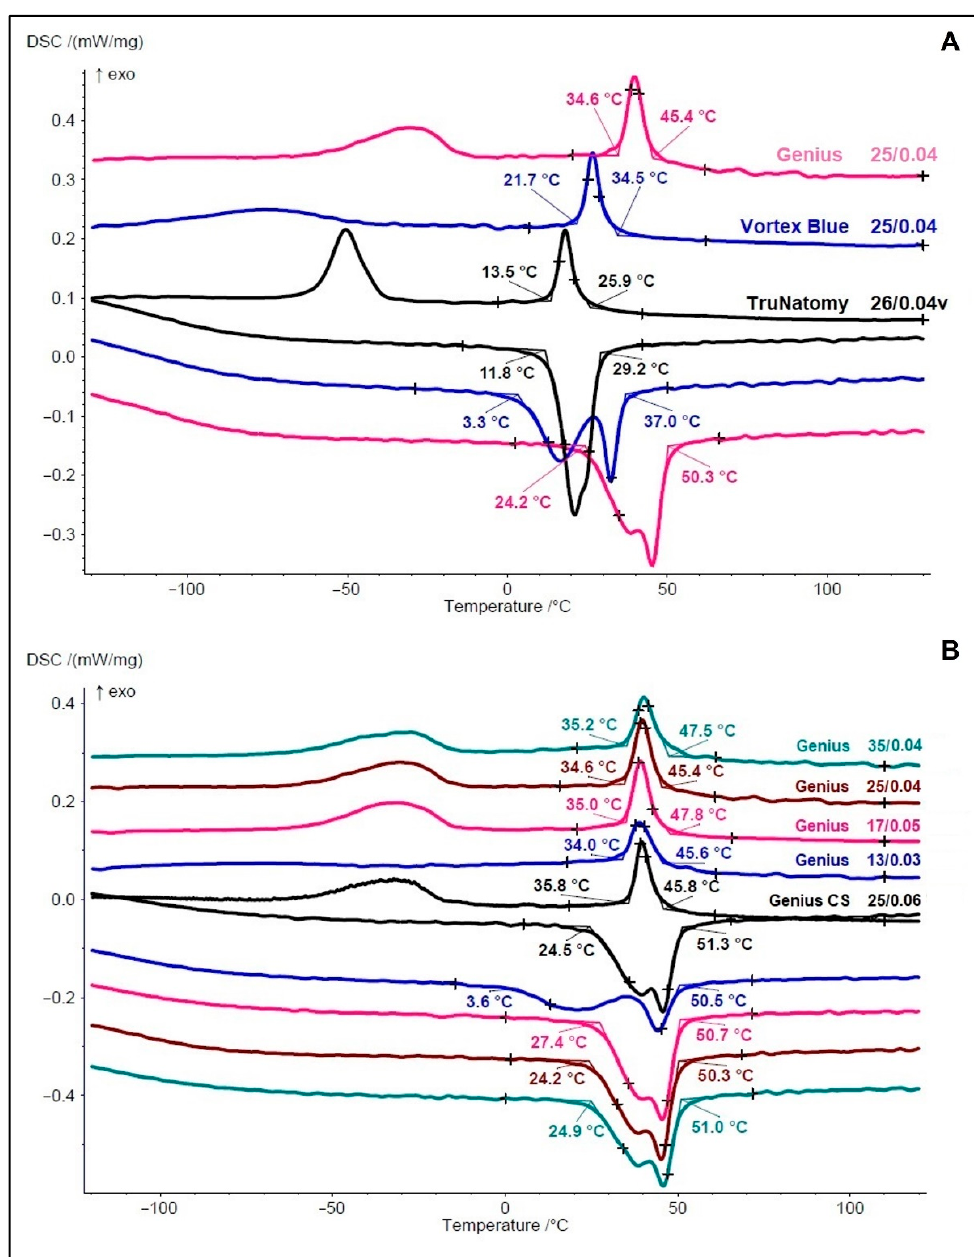
Figure 2. DSC charts showing the phase transformation temperatures at cooling on the top (reads from right to left) and at heating on the bottom (reads from left to right). ( A ) Genius Proflex showed the highest R-phase start (45.4 °C) and finish (34.6 °C) temperatures, while TruNatomy had the lowest (25.9 °C and 13.5 °C, respectively). Genius Proflex also had the highest austenitic start (24.2 °C) and finish (50.3 °C) temperatures. ( B ) Phase transformation temperatures of the Genius Proflex system. Except for the 13/0.03 instrument, which showed a distinct R-phase to martensite B19 ′ transformation at cooling, all other instruments had similar curves.